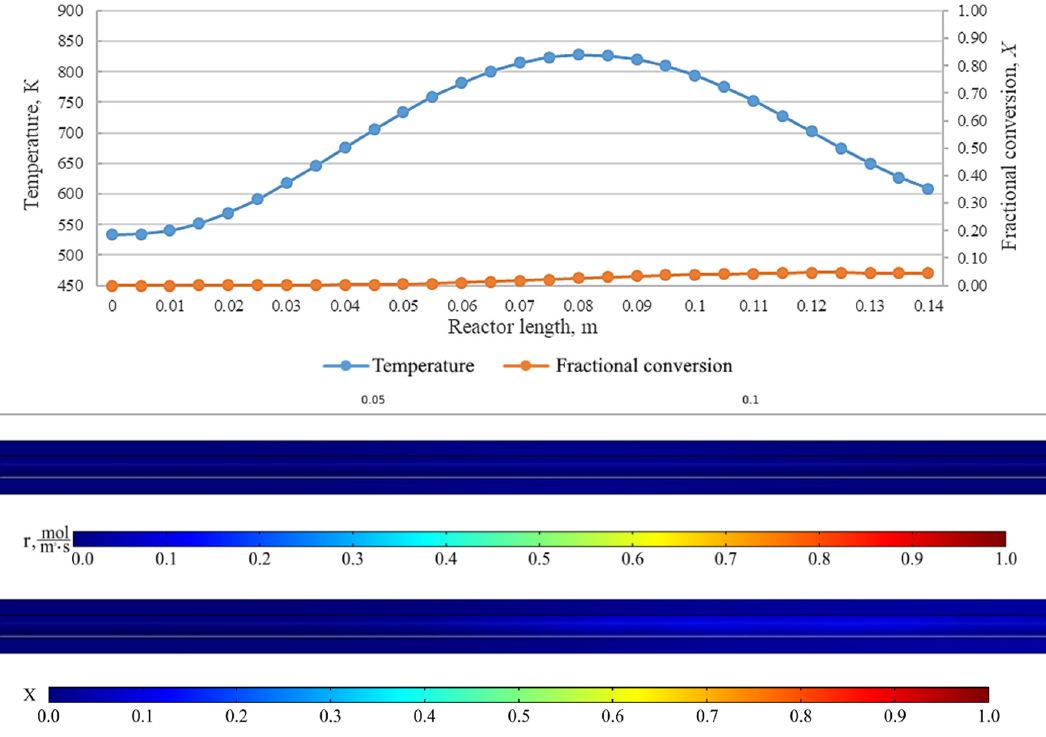
Figure 17. From top to bottom: temperature and fractional conversion curves, profiles of the reaction rate and fractional conversion along the reactor length for the experiment BuOm_550_69 (Tmax = 550 °С , 𝑉(cid:4662) = 3.0 L/min).